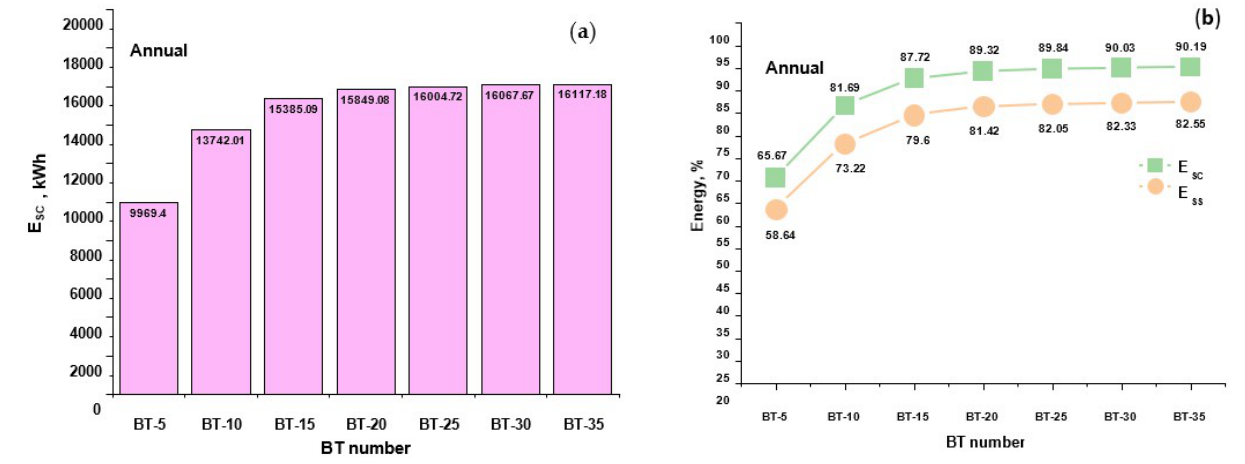
Figure 12 . The annual ( a ) E SC in kWh, ( b ) E SC and E SS in percentage. Figure 13 shows that the net energy is negative, which indicates that part of the energy goes back to the grid, ant this is the amount of energy that exceeds the local amount of energy that is required to charge the battery and feed the local load.